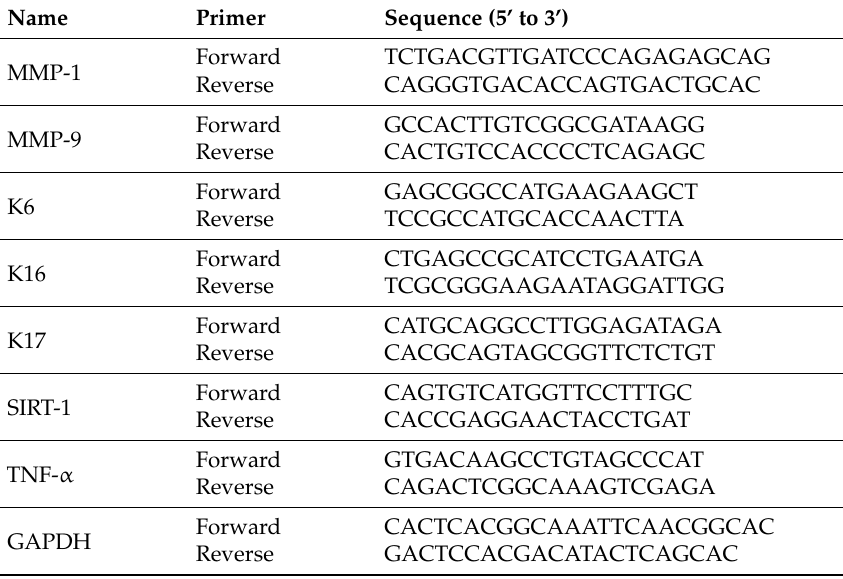
Table 1. Sequences of primers (human) used in semiquantitative